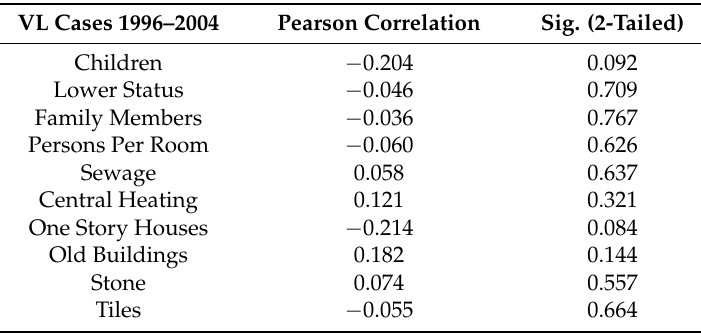
Table 3. Correlations (socioeconomic characteristics).